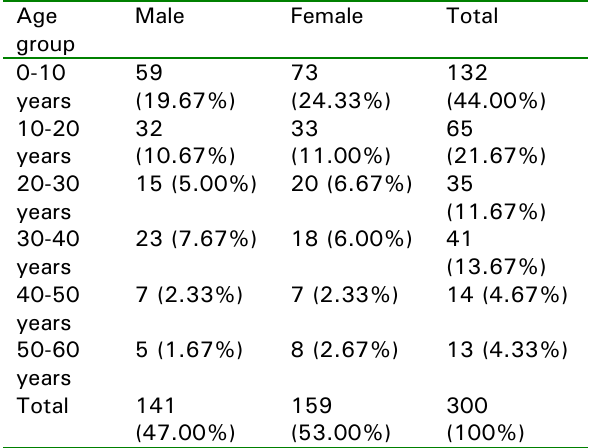
Table 1: Age and sex distribution